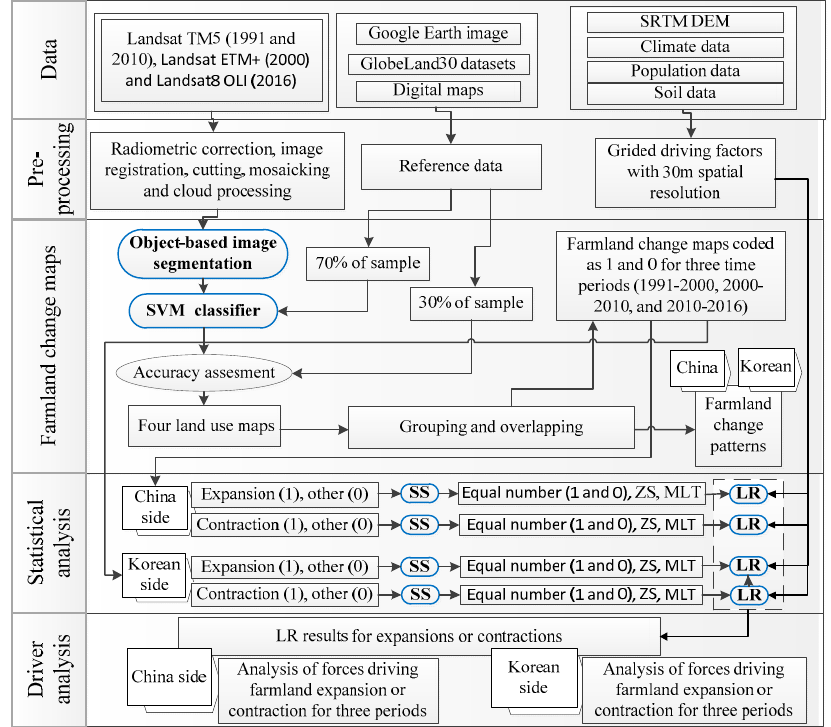
Figure 2. Framework overview of this study. Note: SS indicates spatial sampling; ZS is Z-score standardization; MLT is multicollinearity test; LR is logistic regression model.